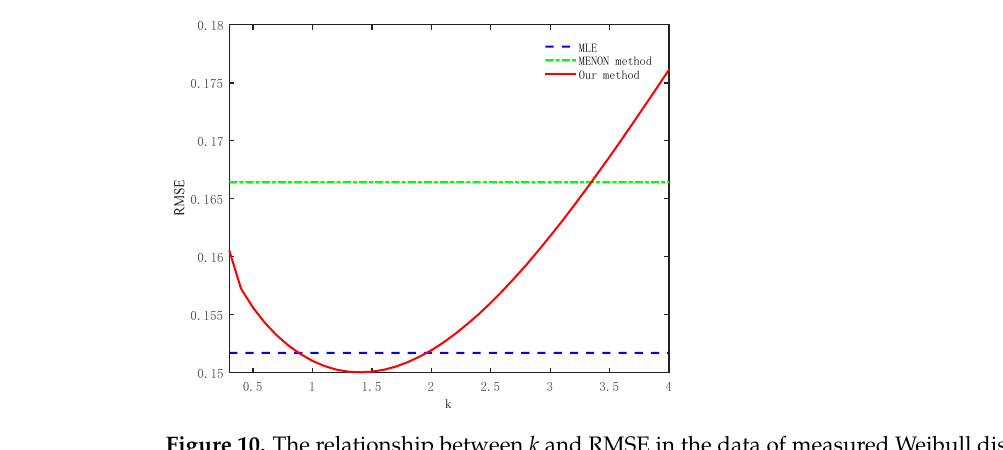
Figure 10. The relationship between k and RMSE in the data of measured Weibull distribution. Table 10. The calculation time in simulated Weibull distribution ( k = 0.5).